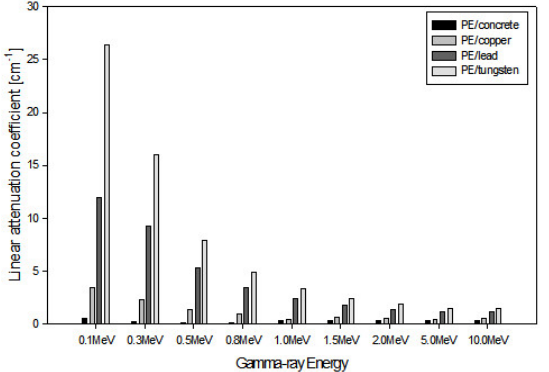
Figure 10. Linear attenuation coefficient of fibrous composite; fiber diameter 0.0461 cm.